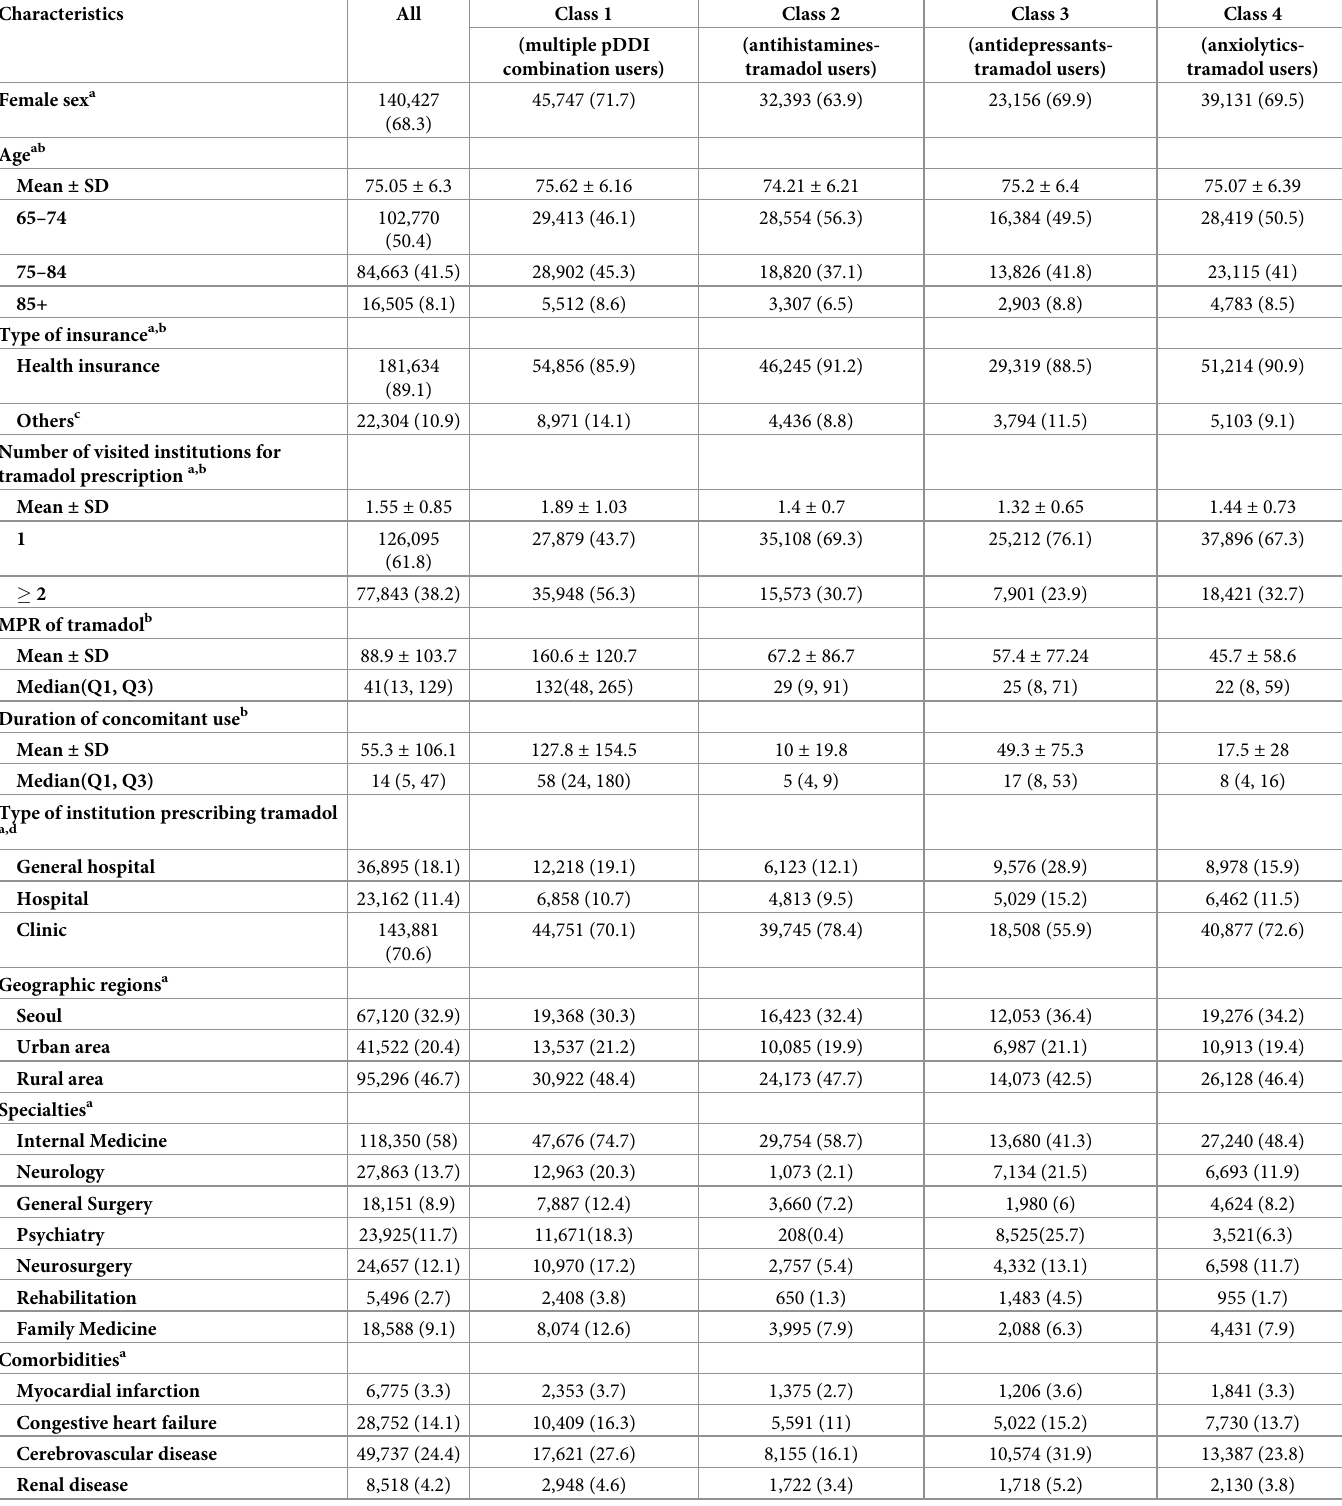
Table 2. Characteristics of the four latent classes of tramadol users with potential drug-drug interactions.